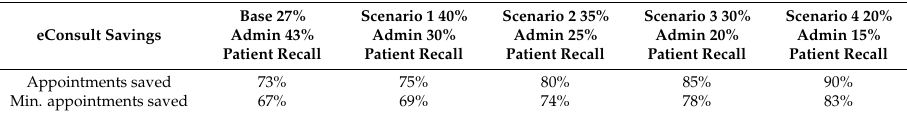
Table 6. Potential GP appointments saved, current and in the 4 scenarios.